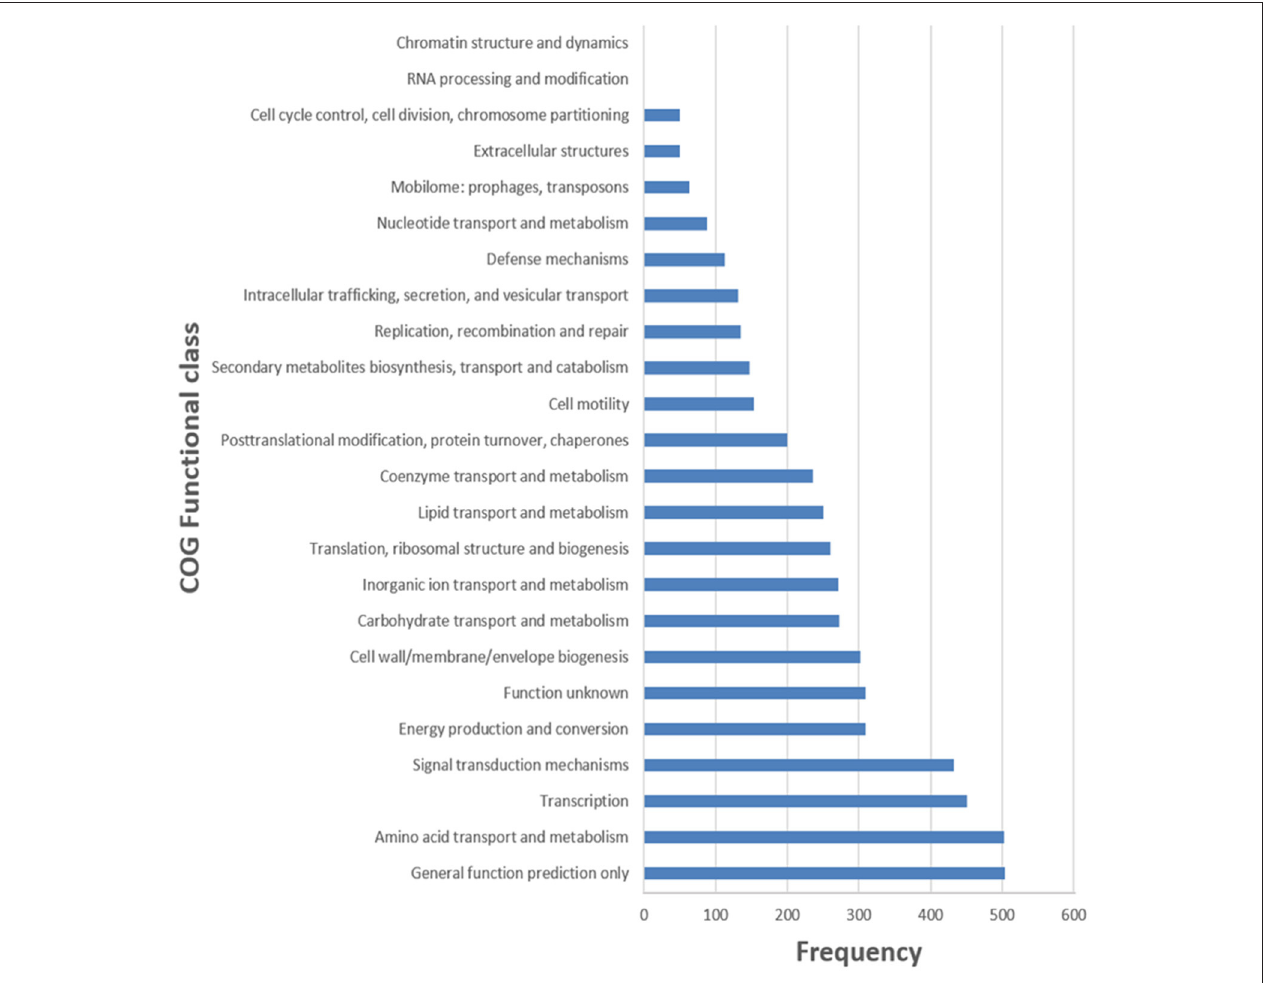
FIGURE 3 | Frequencies of functional COG